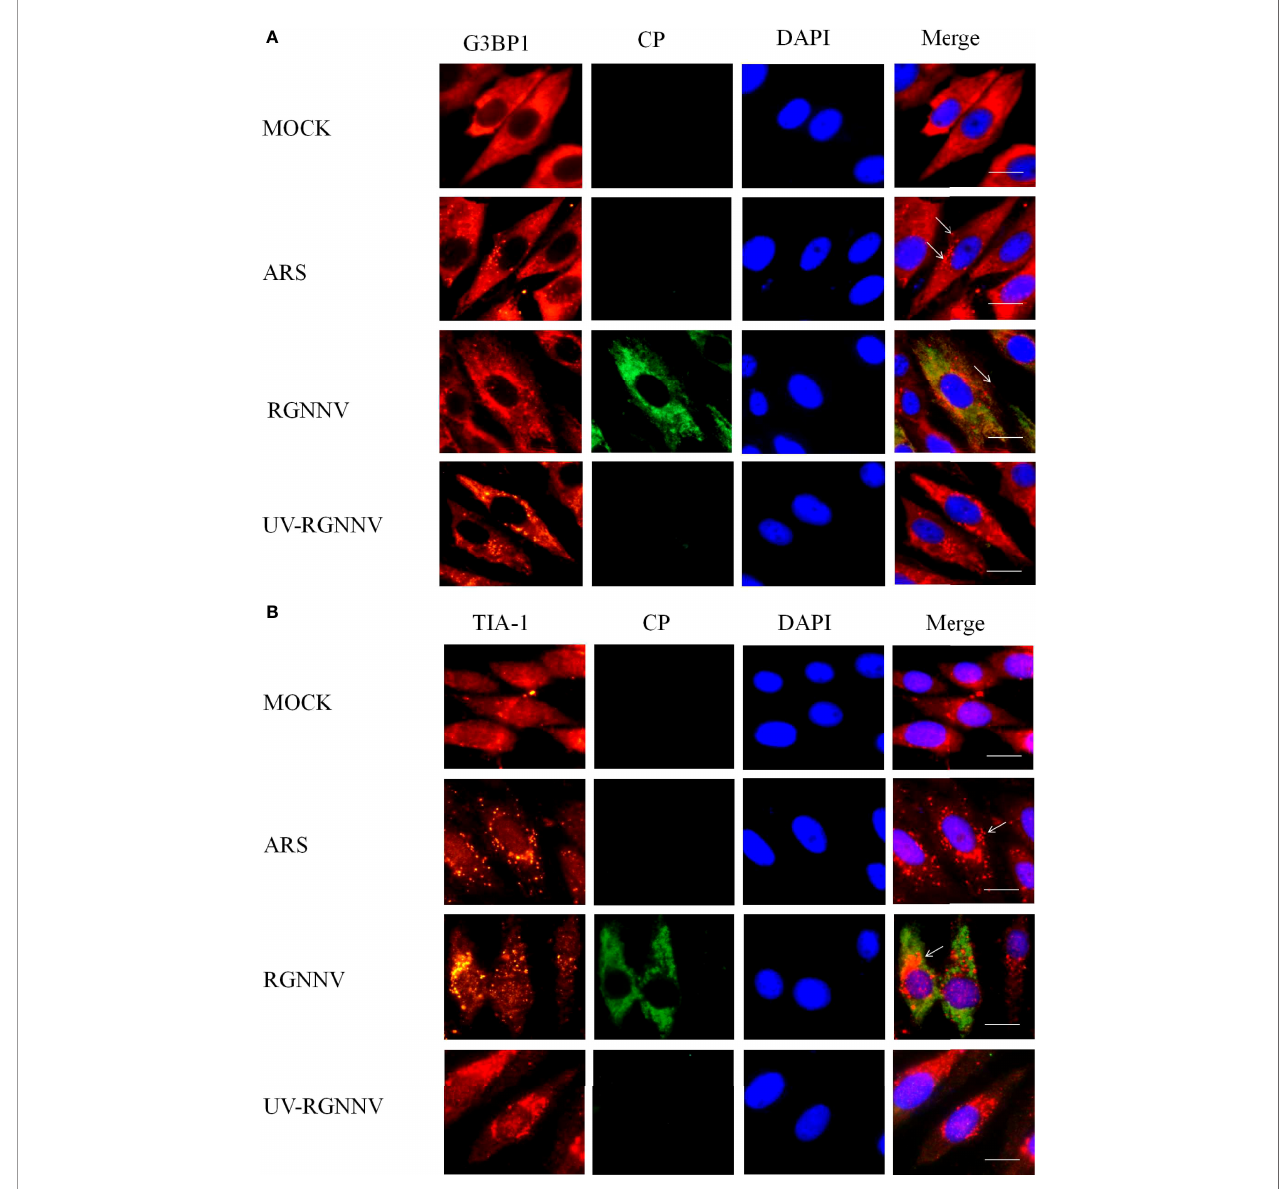
FIGURE 1 | RGNNV infection induced SG production in GS cells. GS cells were fi xed at different times post-RGNNV infection (MOI = 2), and the formation of SGs was observed under a fl uorescence microscope. G3BP1 (red) indicates the presence of SGs, and CP (green) indicates viral infection. The nuclei were stained with DAPI (blue). Scale bars are 10 µm. (A) GS cells were infected with RGNNV or UV-inactivated RGNNV (MOI = 2). The cells were fi xed and stained with anti-G3BP1 antibodies and anti-CP antibodies. (B) GS cells were infected with RGNNV or UV-inactivated RGNNV (MOI = 2). The cells were fi xed and stained with anti-TIA-1 antibodies and anti-CP